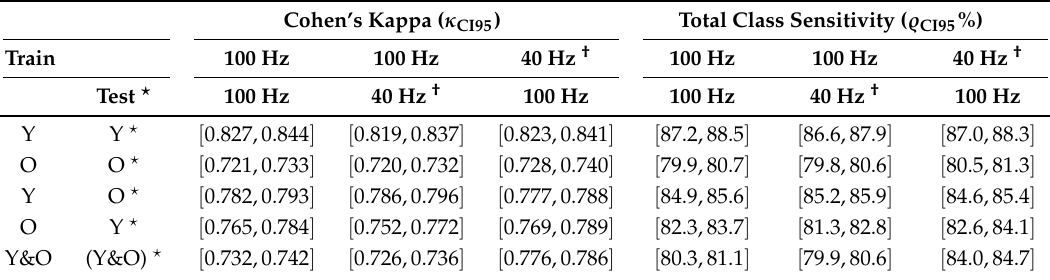
Table 4. Ninety-five percent confidence intervals for the Cohen’s Kappa and total class sensitivity (%) when a hierarchical model of human activity (HMHA) was developed with the Best Features at different sampling